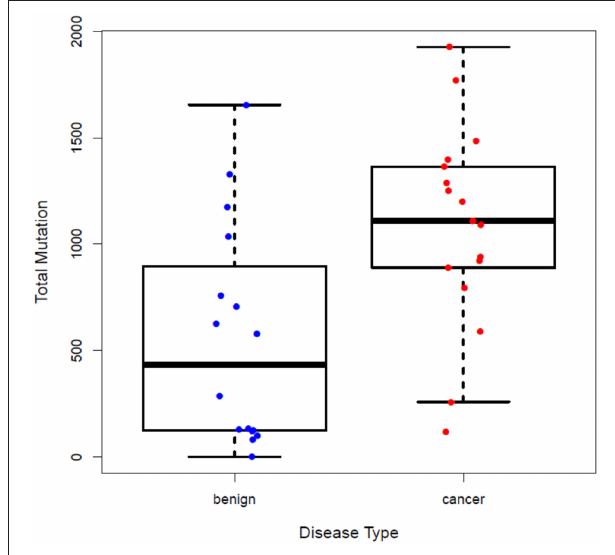
FIGURE 1 | Number of somatic variants detected in the plasma cfDNA of patients in the control and cancer groups. More somatic cfDNA variants were observed in the cancer group than the control group, P =